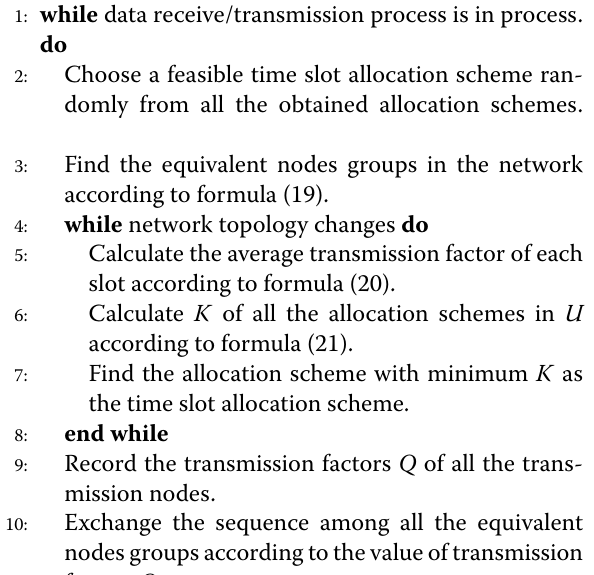
Algorithm 1 Dynamic time slot allocation